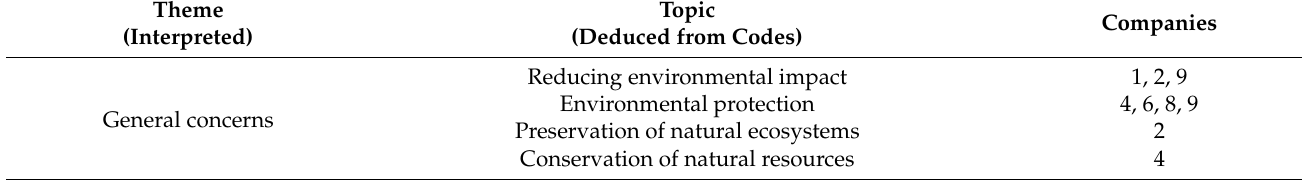
Table 4. Thematic categorization of the environmental notions from the analyzed codes of